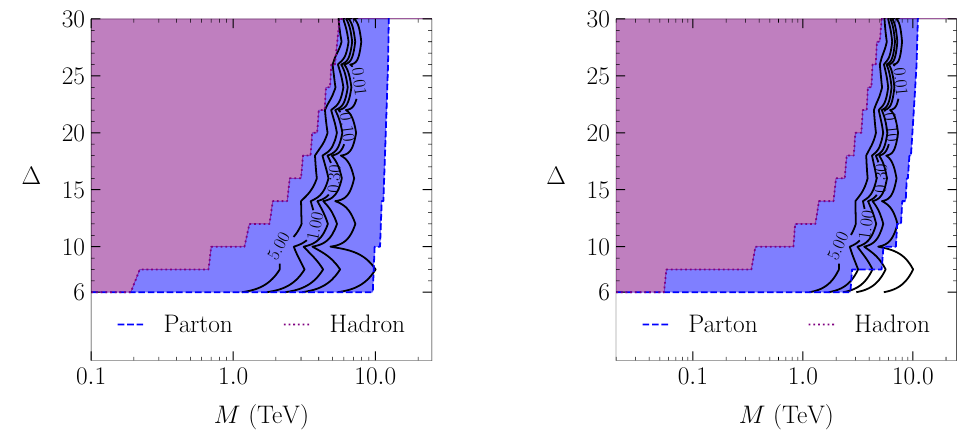
Figure 19 . A comparison of the perturbative unitarity results against the t -channel cross section predictions for two choices of the UV parameters: λ qφ = 8 π [left] and λ qφ = 2 [right] in the case that the final state particles have a mass of 10 GeV. The shaded regions are the perturbative unitarity bounds, while the contours show power counting error.